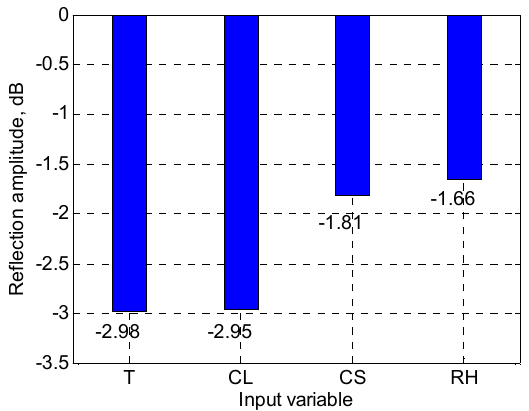
Figure 8. Sensitivity of input parameters to the output.